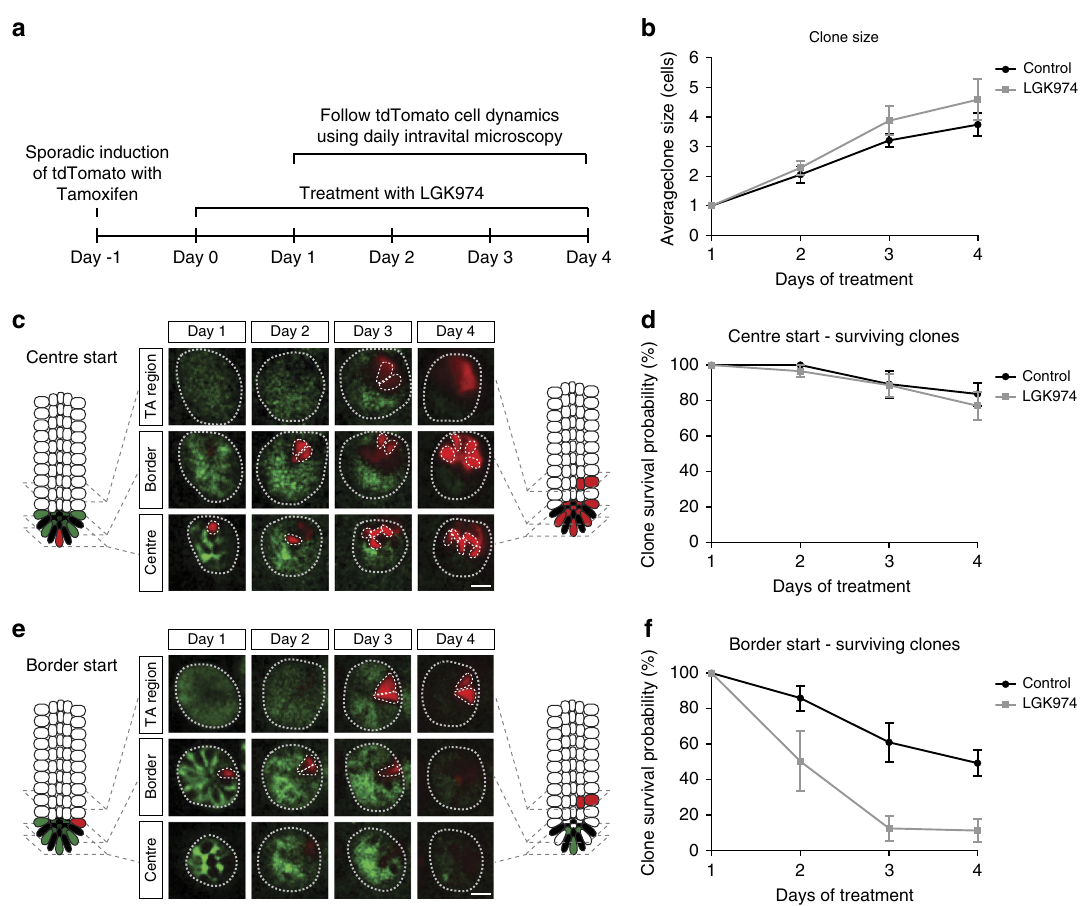
Fig. 3 In vivo live imaging shows speci fi c loss of border stem cells after LGK974 treatment. a Graphical representation of the experimental setup. One day before LGK974 treatment, Lgr5Cre ER tdTom fl mice were injected with 0.05 mg tamoxifen IP to induce recombination in single cells. Mice ( N = 4) were treated with LGK974 and daily intravital imaging was performed starting 1 day after fi rst LGK974 treatment and compared to control mice ( N = 5). b Graph shows mean clone size (43 crypts, control; 56 crypts, LGK974 on day 1) of surviving clones (clones with at least one cell in centre or border) over time within the centre and border. Note that cells in the transit amplifying (TA) cell region are not counted. c , e Intravital images of the same crypt on days 1 – 4 following a clone starting in the centre ( c ) and a clone starting in the border ( e ). d , f Graphs show the percentage of clones that still have at least one cell in the centre or border starting from centre cell (17 crypts, control; 36 crypts, LGK974) ( d ) or from border cell (26 crypts, control; 20 crypts, LGK974) ( f ). Error bars = s.e.m. Scale bar, 20 µ